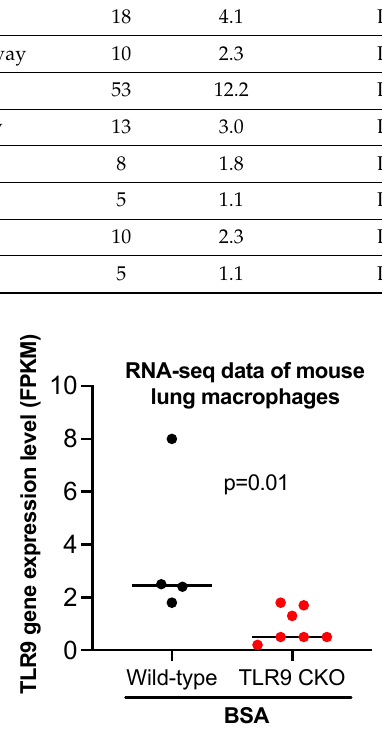
Figure 5. Bulk RNA-sequencing data showing reduced TLR9 gene expression in lung macrophages isolated from TLR9 CKO mice treated with BSA as compared to the cells from TLR9-sufficient mice treated with BSA. FPKM stands for fragments per kilobase of transcript per million mapped reads, indicating a relative expression of a gene proportional to the number of cDNA fragments of origin. n = 4 to 7 mice per group. List of genes in selected pathways altered by palmitic acid in wild-type mouse lung